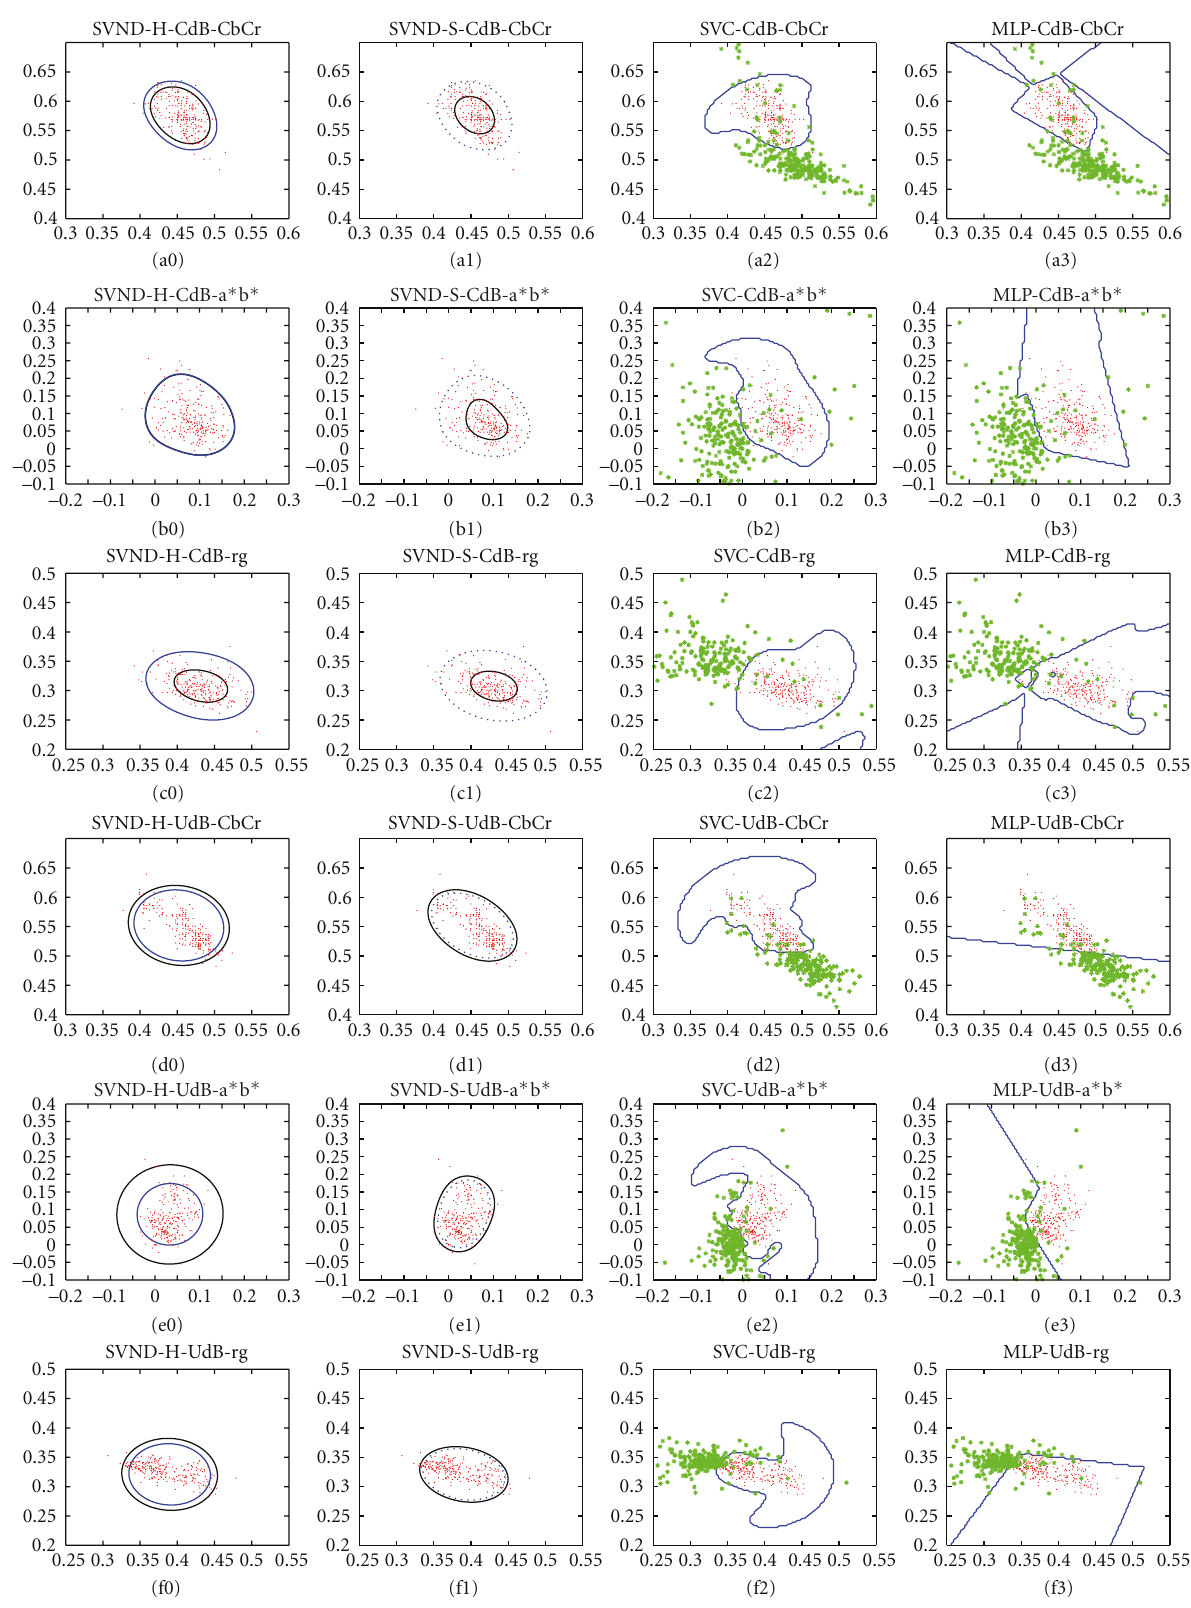
Figure 4: Training samples (skin in red, nonskin in green) and skin boundaries (continuous for SVND threshold, dashed for EER threshold), obtained from the nonparametric models (each column corresponds to a model: SVND-H in ∗ 0, SVND-S in ∗ 1, SVM in ∗ 2, and MLP in ∗ 3). CdB with CbCr in a ∗ , CdB with a (cid:2) b (cid:2) in b ∗ , CdB with rg in c ∗ , UdB with CbCr in d ∗ , UdB with a (cid:2) b (cid:2) in e ∗ , UdB with rg in f ∗